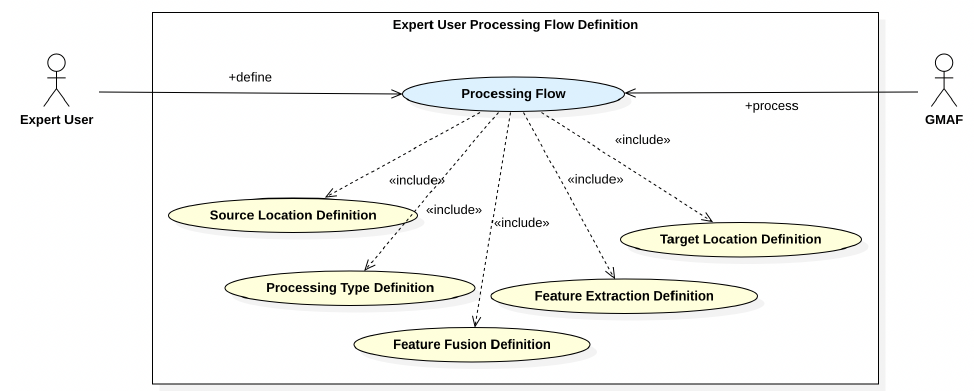
Figure 6. Expert use case for feature fusion and processing flow